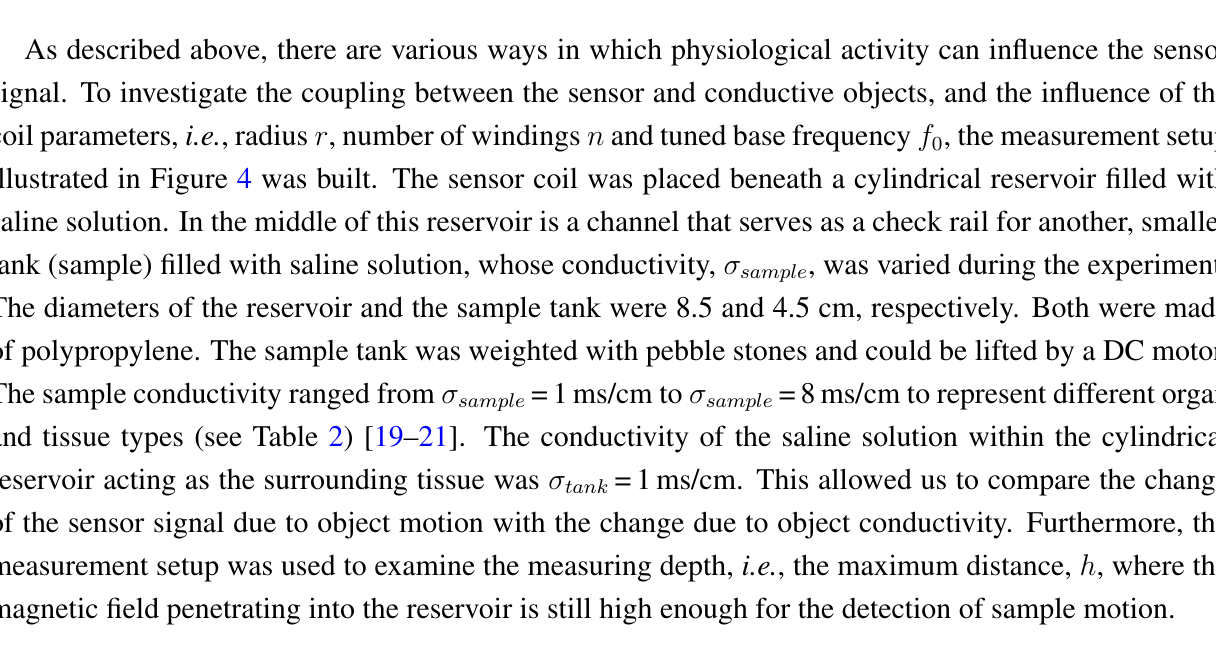
Figure 4. Measurement setup for the examination of sensor response and measuring depth.